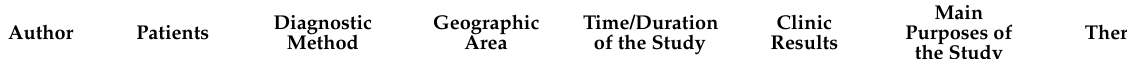
Table 4. IBD-treatment and COVID-19: risks and